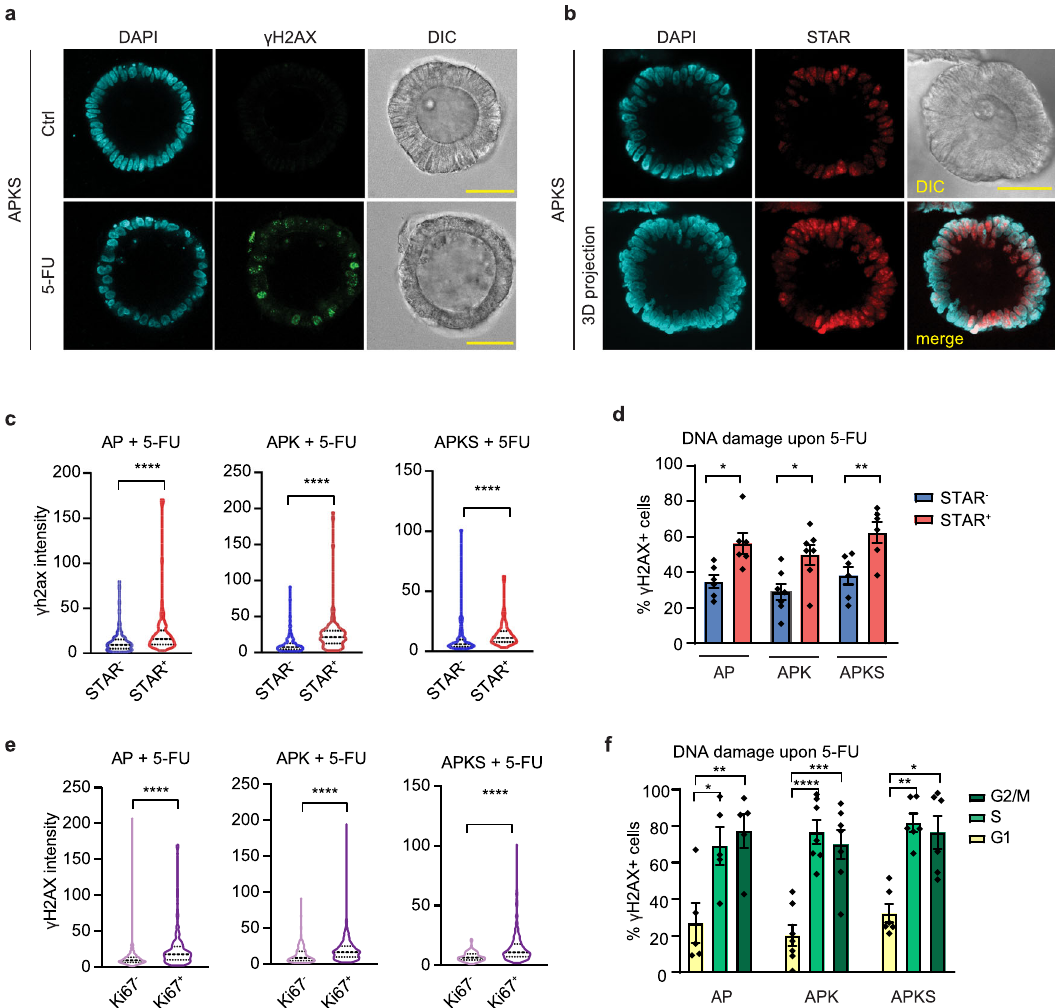
Fig. 2 5-FU induces DNA damage in a proliferating subpopulation of tumor cells. a Representative images of APKS organoids treated with 5-FU for 48 h and stained with anti- γ H2AX and DAPI (scale bar = 50 µ m). b Representative images of APKS organoids transduced with the stem cell reporter STAR and stained with DAPI (scale bar = 50 µ m, upper panel: single Z-stack, lower panel: maximal projection of Z-stacks). c Quanti fi cation of γ H2AX intensity in STAR − and STAR + cells of immuno fl uorescent images of AP, APK, and APKS organoids treated with 5-FU for 48 h (Supplementary Fig. 2f) (70-153 cells per condition from 12 organoids from three independent experiments, Mann – Whitney test). d Detection of γ H2AX + cells by fl ow cytometry in STAR - vs STAR + cells of AP, APK and APKS organoids treated with 5-FU for 48 h (mean ± SEM, n = 6 (AP, APKS), 7(APKS), one-way ANOVA, Sidak ’ s multiple comparisons test). e Quanti fi cation of γ H2AX intensity in KI67 + vs KI67 - cells of immuno fl uorescent images of AP, APK, and APKS organoids treated with 5-FU for 48 h (Supplementary Fig. 2G) 128-331 cells per condition from 12 organoids from three independent experiments, Mann – Whitney